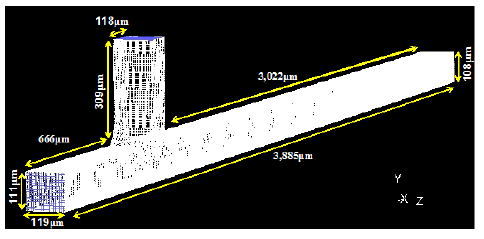
Figure 9. Computational T-junction mesh volume (5.67 µ m